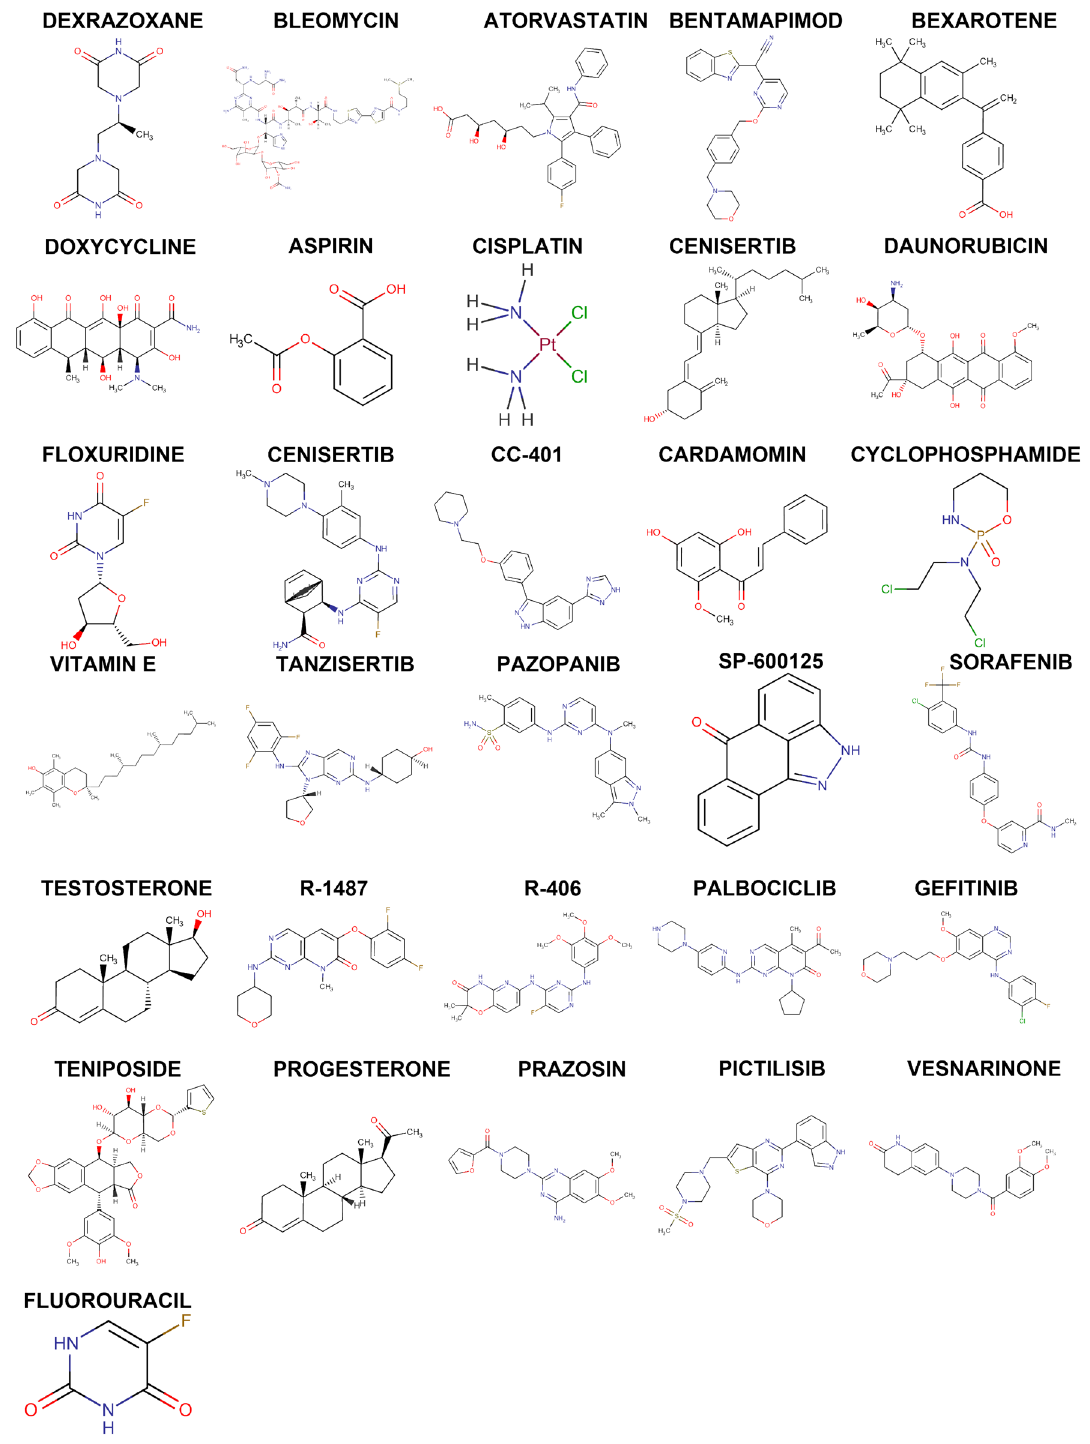
Figure 7. Chemical structure formula of the targeted